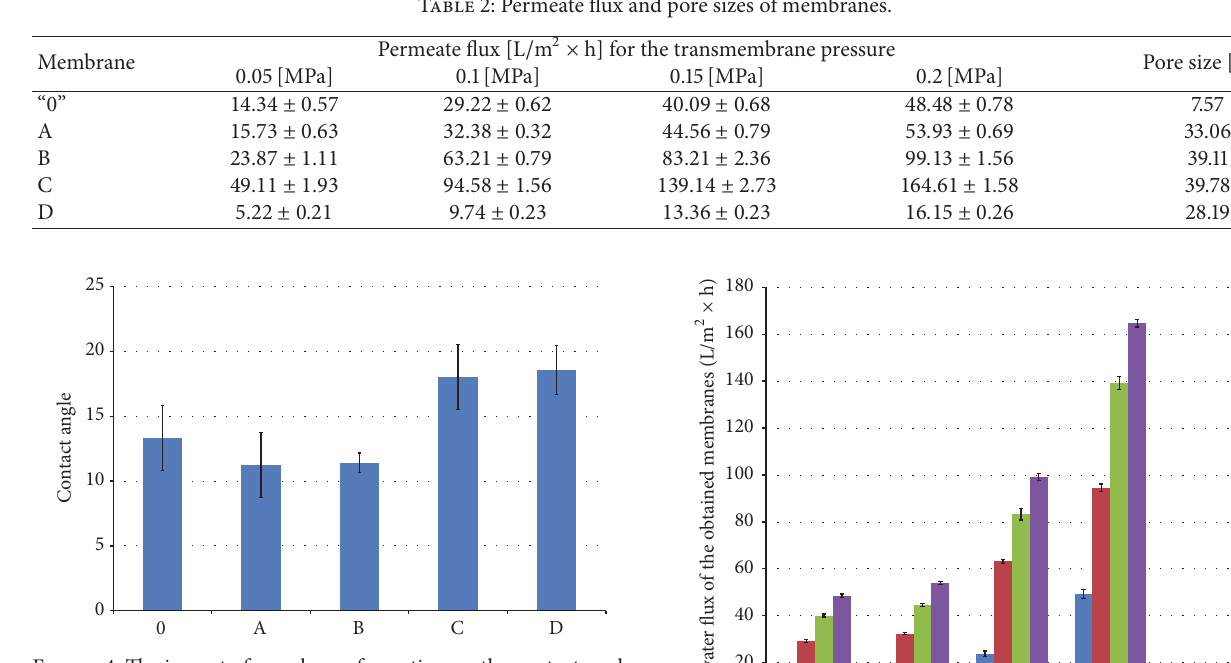
Figure 4: The impact of membrane formation on the contact angle values.